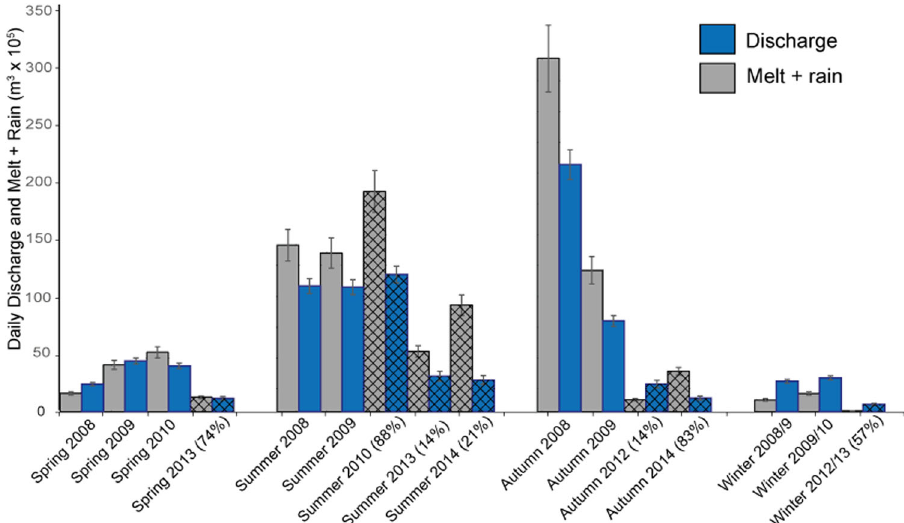
Fig. 3 Mean daily inputs (melt and rain) and discharge per season. Where a full record for discharge was not available (shown with hatching), the percentage days of the record are shown. Data for 2008 – 2010 for Skálafellsjökull north, 2012 – 14 Sultartungnajökull catchment. The calculation of error is explained in ‘ Methods ’ , in the ‘ Melt estimate ’ and ‘ Discharge ’ sections.